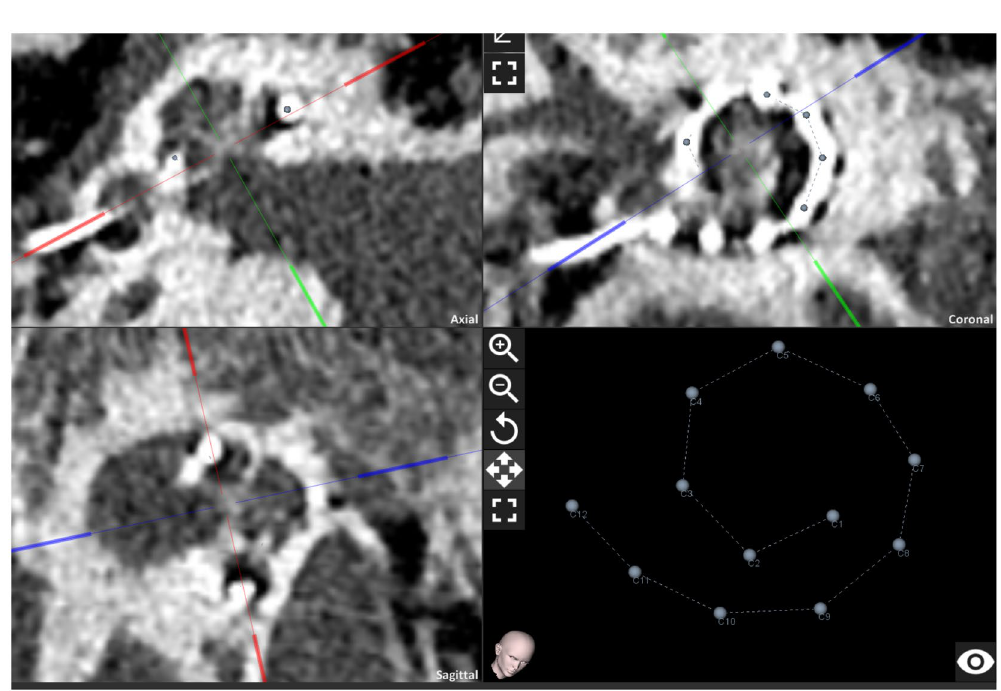
Figure 5. Postoperative tool of the planning software. User defined cochlear view and coordinate system by blue, green and red crosshairs and selected centre point of each electrode contact in the planning